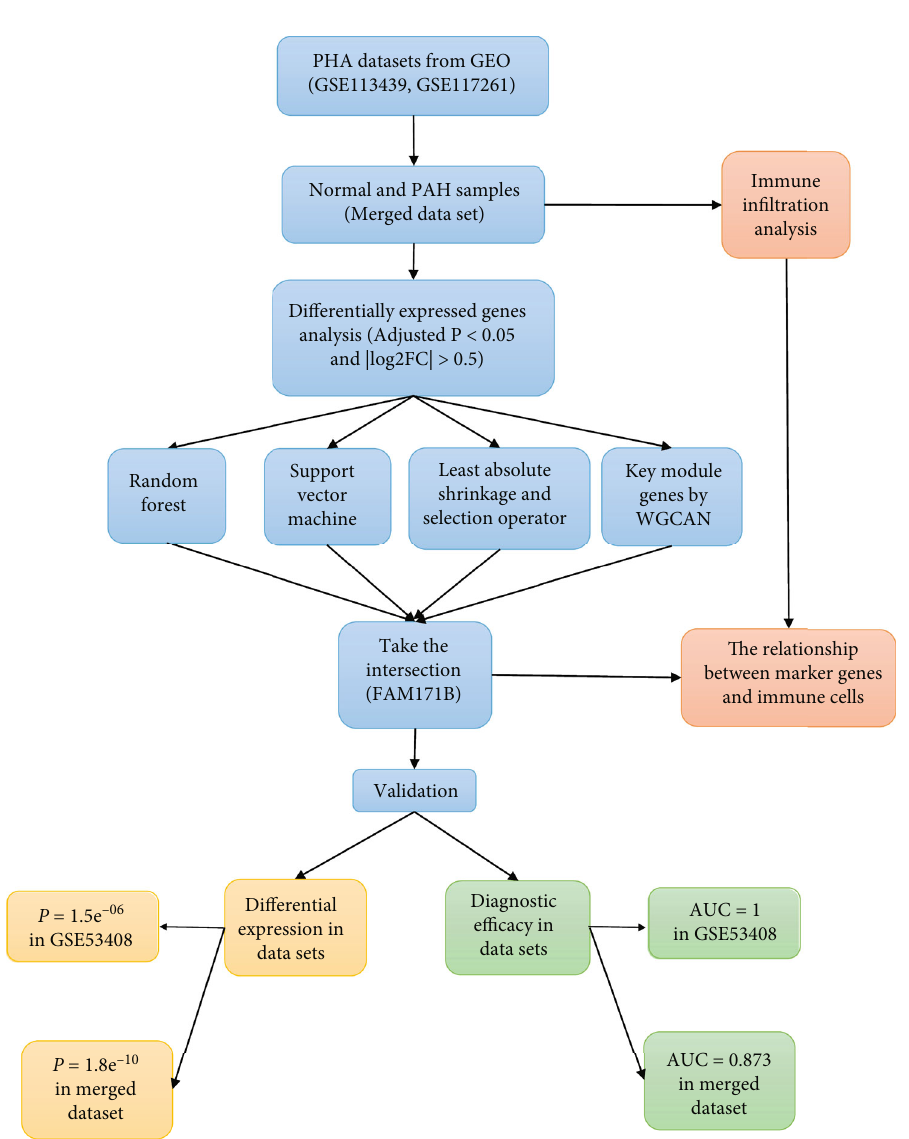
Figure 1: Work fl ow for the